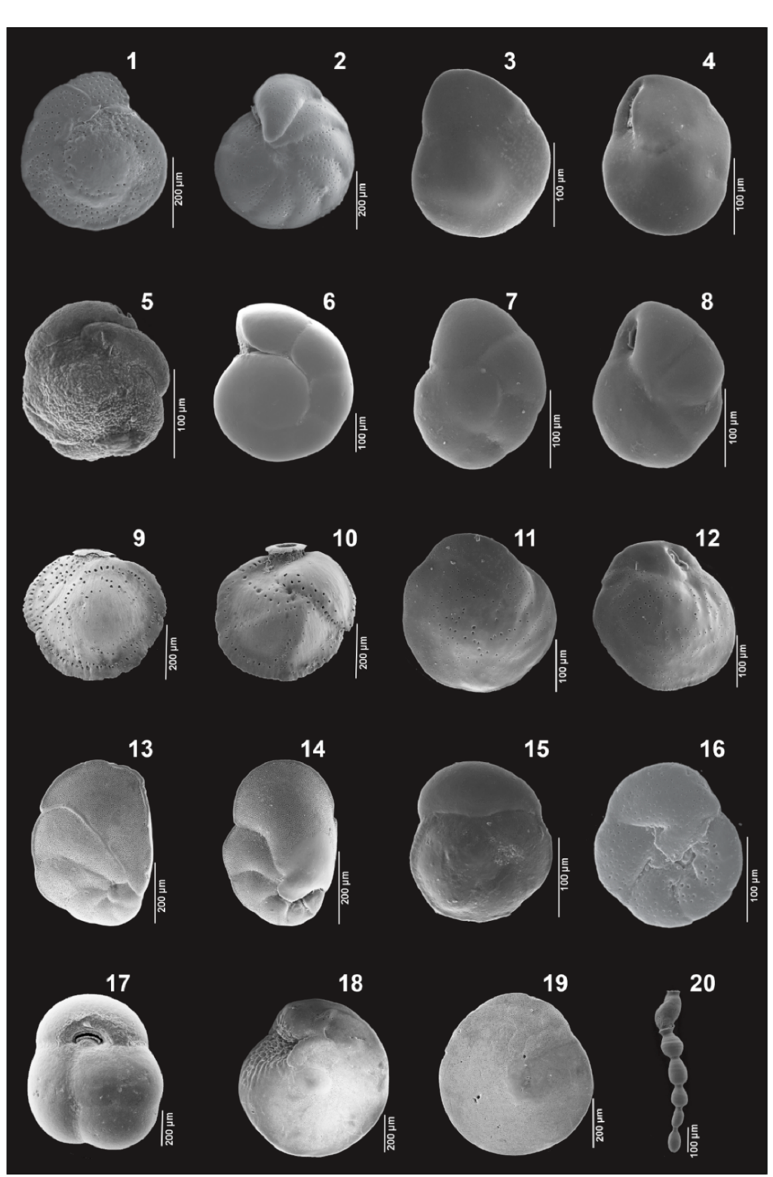
Figure A4. Plate IV: 1,2— Cibicidoides mundulus (Brady, Parker & Jones, 1888): 1—spiral view; 2—umbilical view; 3,4— Epistominella exigua (Brady, 1884): 3—spiral view; 4—umbilical view; 5— Nuttallides umbonifer (Cushman, 1933), spiral view; 6— Gyroidina sp. 2, spiral view; 7,8— Epistominella sp. 1, 7—spiral view; 8—umbilical view; 9,10— Siphonina bradyana Cushman, 1927, 9—spiral view; 10— umbilical view; 11,12— Cassidulina curvata Phleger & Parker, 1951: 11—side view; 12—side view showing the aperture; 13,14— Cancris auricula (Fichtel & Moll, 1798): 13—spiral view; 14—umbilical view; 15,16— Gavelinopsis sp. 1: 15—spiral view; 16—umbilical view; 17— Sphaeroidina bulloides d’Orbigny in Deshayes, 1828, apertural view; 18,19— Amphistegina gibbosa d’Orbigny, 1839, 18—side view showing the aperture; 19—side view; 20— Resigella moniliformis (Resig, 1982), side view.